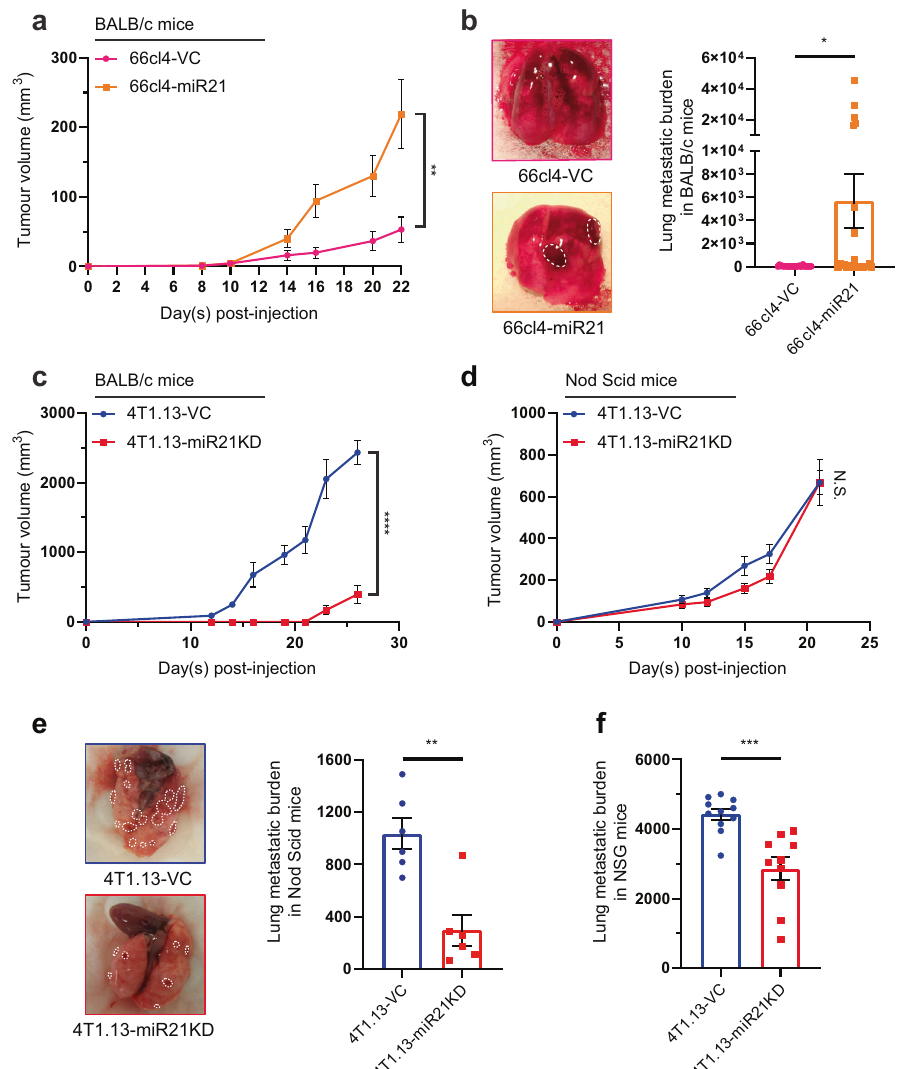
Fig. 3 miR-21 promotes tumour growth and metastasis through immune-dependent and immune-independent mechanisms. a Effect of enhanced expression of miR-21 on the growth of 66cl4 tumours following inoculation of 1 × 10 5 cells into the mammary fat pad of BALB/c mice. Mean ± SEM shown for each timepoint. n = 17 for the 66l4-VC group, n = 15 for the 66cl4-miR-21 group. b Spontaneous metastasis to lung following growth of 66cl4-VC or 66cl4-miR-21 mammary tumours (inoculation of 5 × 10 5 cells) measured by qPCR of the reporter gene (mCherry) expressed in the tumour cells. Primary tumours were resected at the same size (~350 mm 3 ). Mean ± SEM ( n = 25/group). Representative images of lungs at the time of necropsy shown with dotted white lines delineating metastatic nodules. c Effect of inhibition of miR-21 activity on the growth of 4T1.13 mammary tumours following inoculation of 2 × 10 5 cells into the mammary fat pad of BALB/c mice. Mean ± SEM ( n = 8 for the 4T1.13-VC group and n = 9 for the 4T1.13-miR-21-KD group). d Effect of inhibition of miR-21 activity on the growth of 4T1.13 mammary tumours following inoculation of 2 × 10 5 cells into the mammary fat pad of NOD-SCID mice. Mean ± SEM ( n = 6/group). e , f Spontaneous metastasis of 4T1.13-VC and 4T1.13-miR-21-KD cells to lungs of NOD-SCID mice e (mean ± SEM, n = 6/group). and to lungs of NSG mice f (mean ± SEM, n = 10/group). For the NOD-SCID mice, representative images of lungs at the time of necropsy are shown with dotted white lines delineating metastatic nodules. * p < 0.05; ** p < 0.01; *** p < 0.001; **** p <